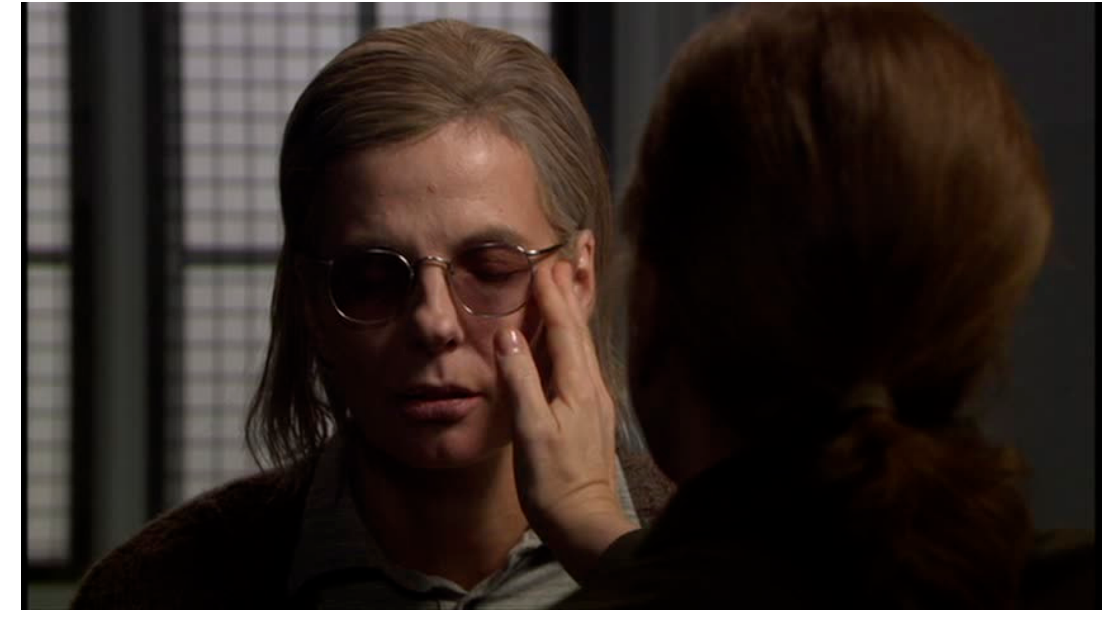
Figure 23. Silence, Touch, Communion.